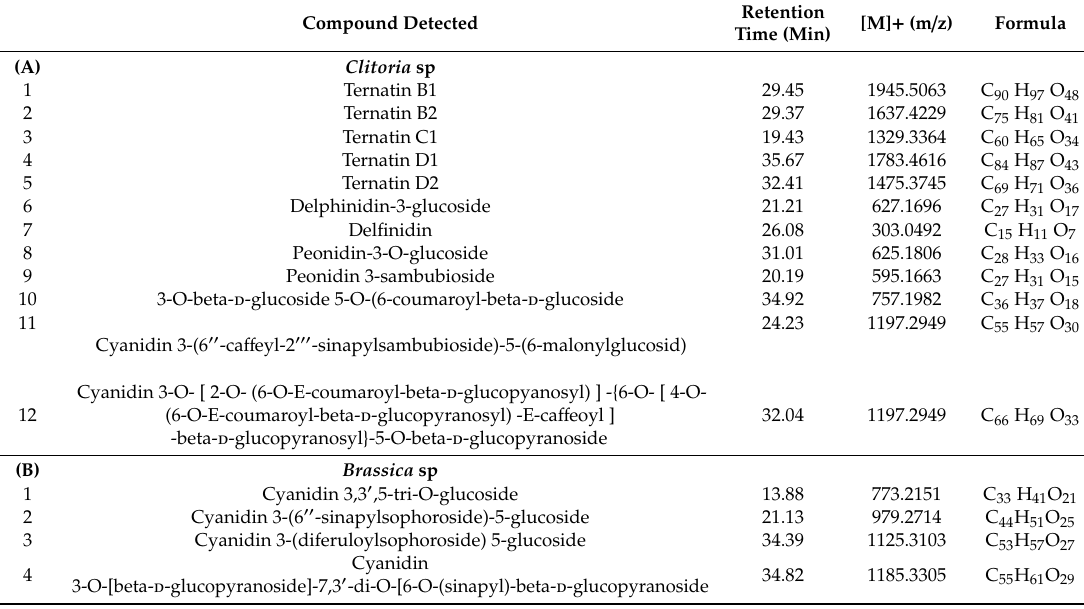
Table 1. Extract compound detected using LCMS-QTOF-MS / MS for ( A ) Clitoria sp; ( B ) Brassica